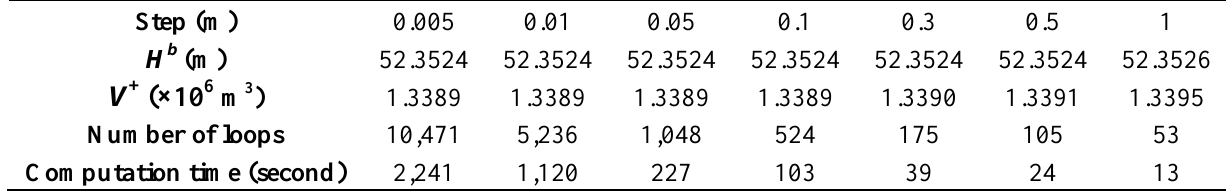
Table 6. The computational accuracy and efficiency of MBM with different H b step